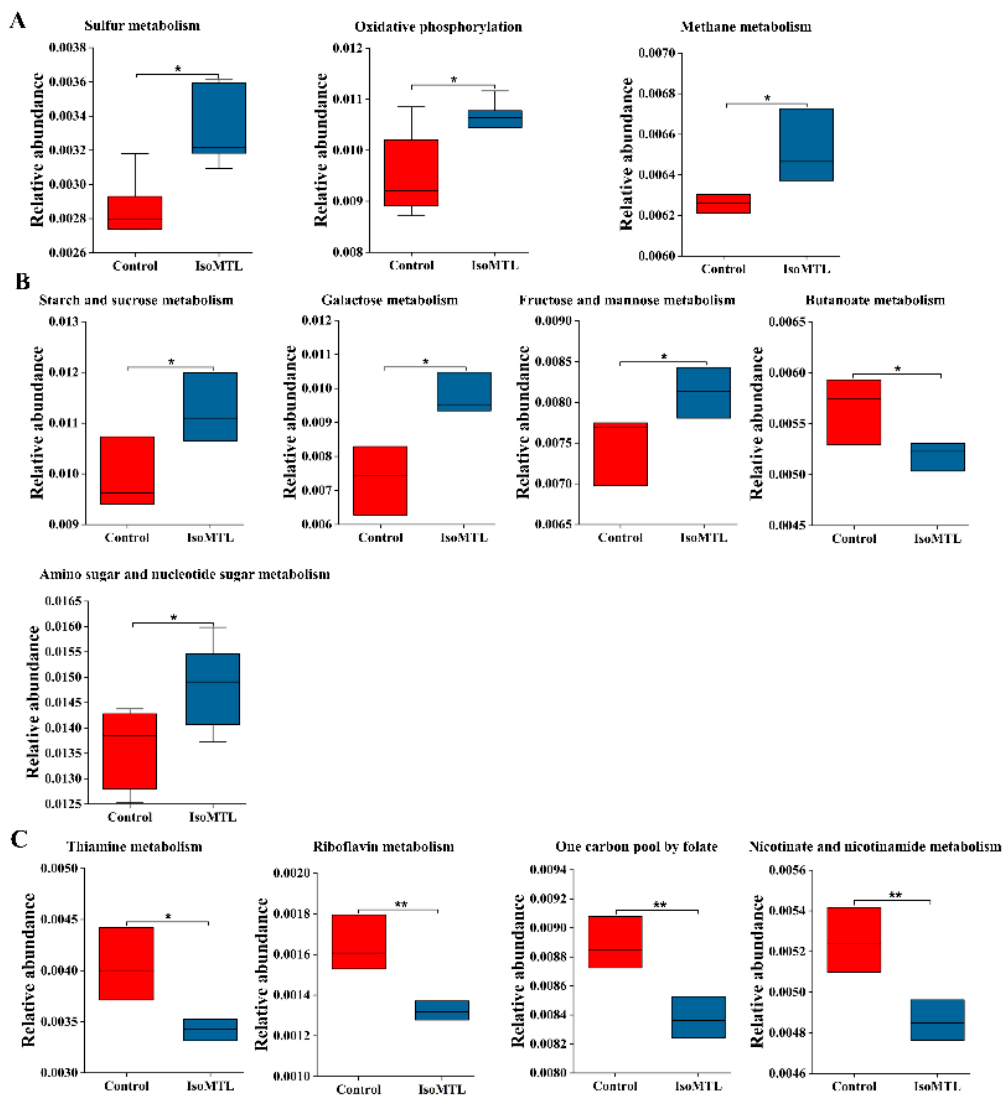
Figure 7. Predicted intestinal microbial functions by PICRUSt2 using 16S rRNA sequencing data. ( A ) Energy metabolism. ( B ) Carbohydrate metabolism. ( C ) The biosynthesis of cofactors and vitamins. * represents the differences between control and IsoMTL rats (* p < 0.05, ** p < 0.01).